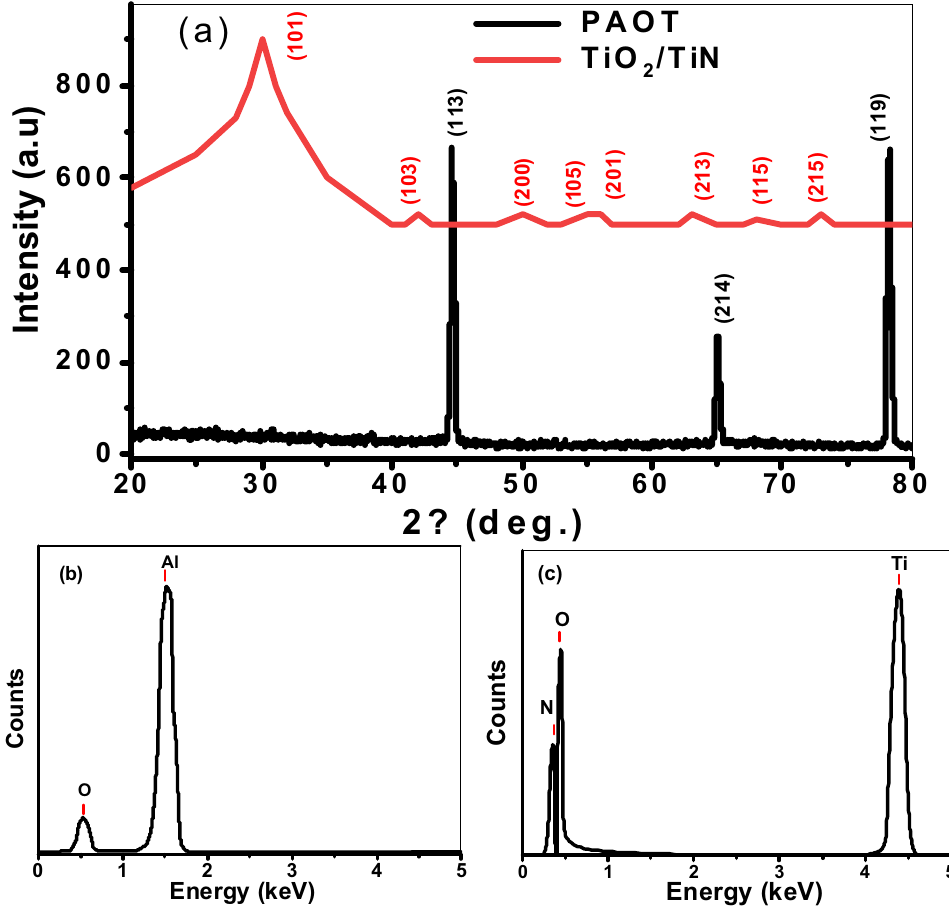
Figure 3. ( a ) The XRD pattern for PAOT and TiO 2 /TiN, ( b ) EDX chart of PAOT, and ( c ) EDX spectra of TiO 2 /